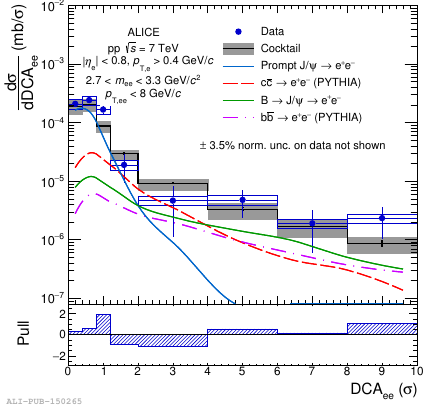
Figure 3. Dielectron spectrum as a function of DCA ee for 2.7 < m ee < 3.3GeV/ c 2 [1].